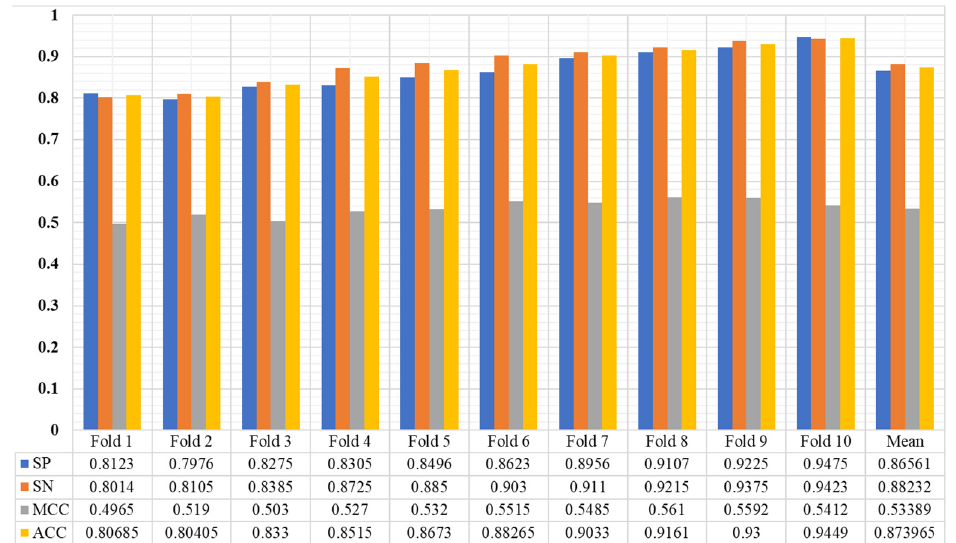
Figure 3. The performance of the proposed model using benchmark enhancers sequence datasets.